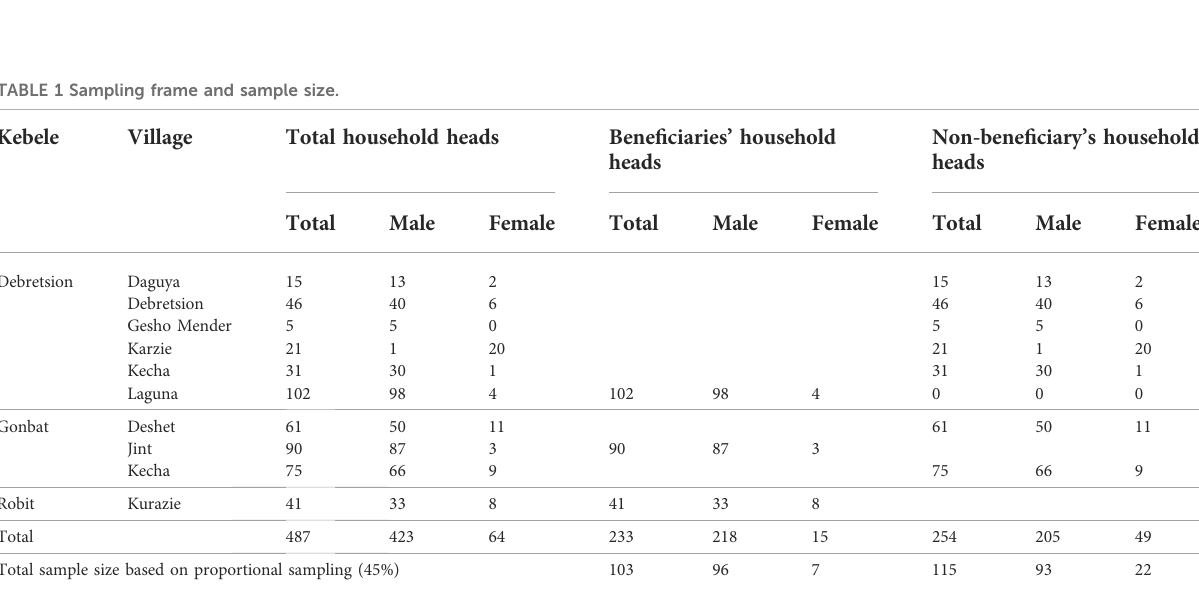
TABLE 1 Sampling frame and sample size. Kebele Village Total household heads